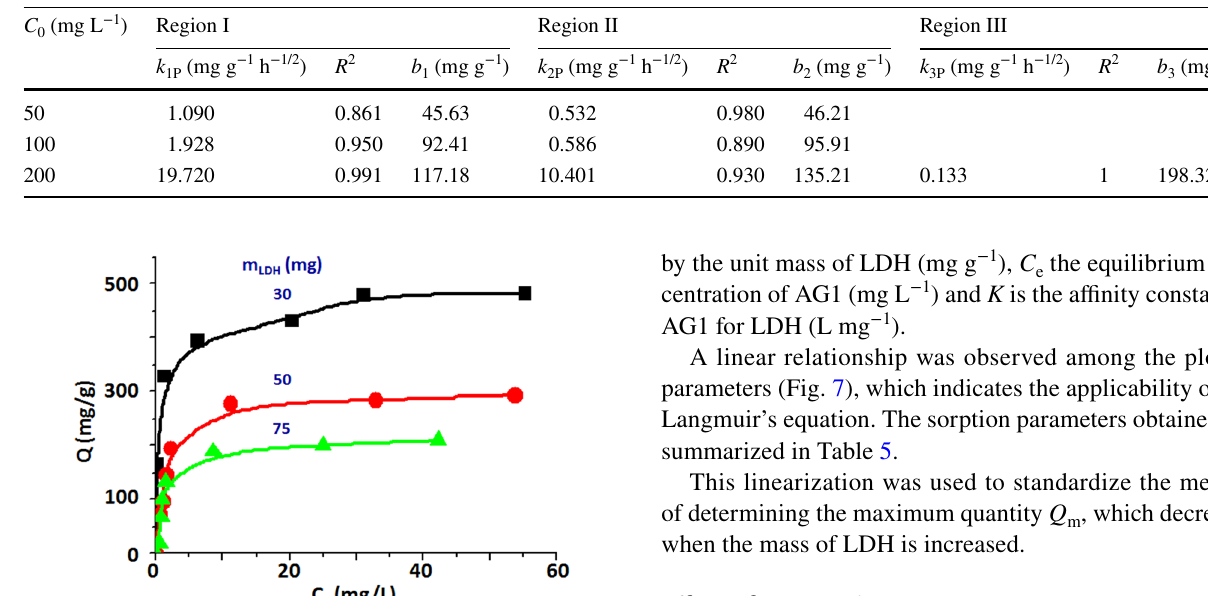
Table 4 Rate constants and correlation coefficients for intra-particle diffusion for adsorption of AG1 on LDH